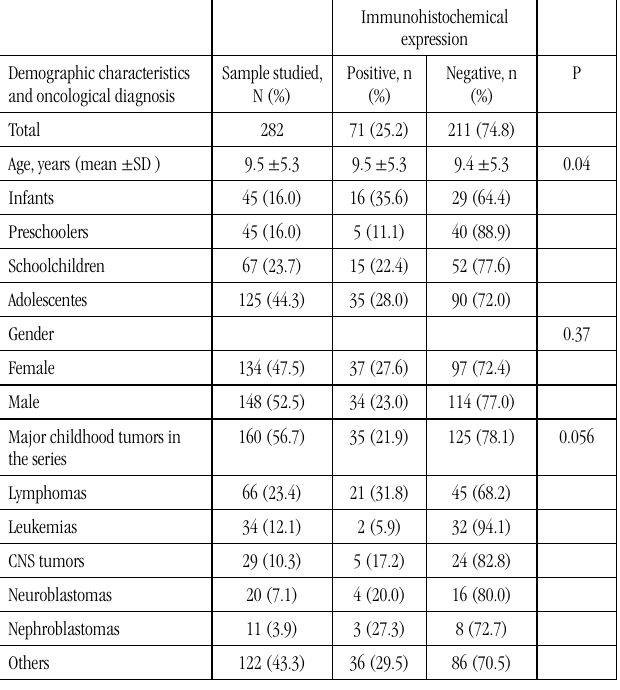
Immunohistochemical expression